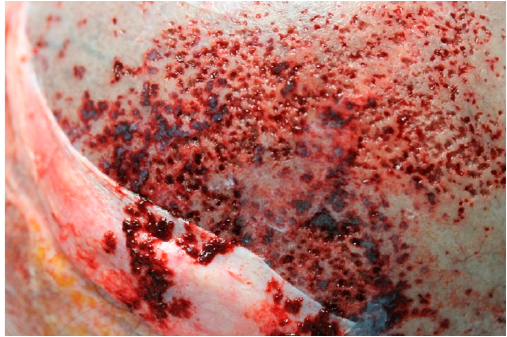
Figure 1. Skullcap erosion, parietal bone. Macroscopic finding. The right thyroid lobe was enlarged due to a 2.5 cm diameter mass, compact and greyish on section. Lungs (Figure 2a) were utterly increased in weight, hyper-inflated,